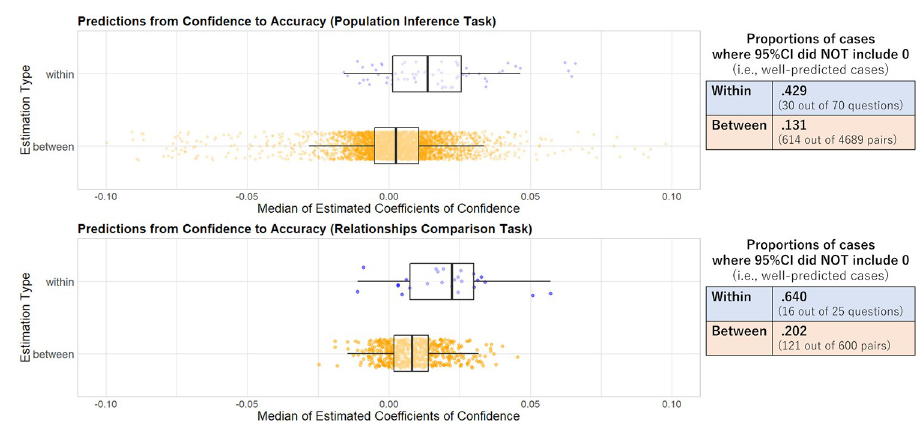
Fig 5. Distributions of medians of the estimated coefficients of confidence in “within-questions” cases (blue) and “between-questions” cases (orange), and proportions of cases where 95% credible intervals did not include zero (right tables). Using a generalized linear model, we predicted the accuracy of one question based on participants’ confidence ratings in the same question (within-questions), or from those in another question (between-questions). We assumed correct/false (1/0 dummy) as a dependent variable and confidence ratings as the independent variable, and estimated the parameter of the coefficient of confidence using an MCMC method (3,000 iterations, 1,500 warm- ups, and 3 chains). Upper: population inference task. Lower: relationships comparison